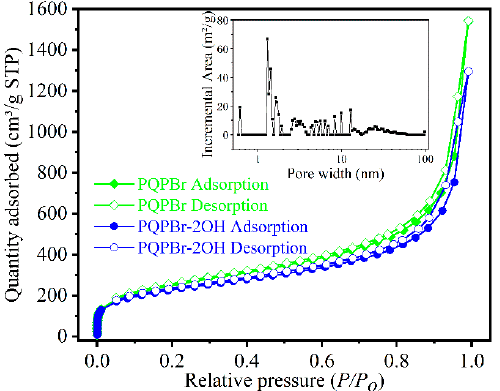
Figure 1. Nitrogen sorption isotherms of PQPBr and PQPBr ‐ 2OH, and pore size distribution curve ( inset ) of PQPBr ‐ 2OH.